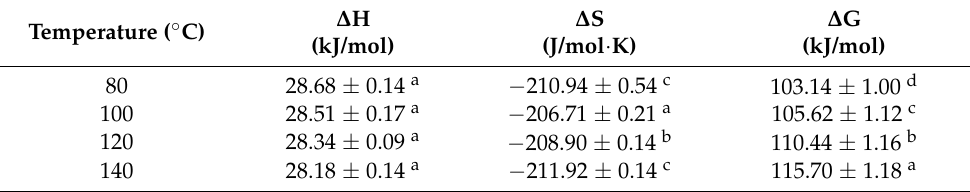
Table 4. Thermodynamic parameters obtained for TPC degradation in red grape skin extract. Temperature ( ◦